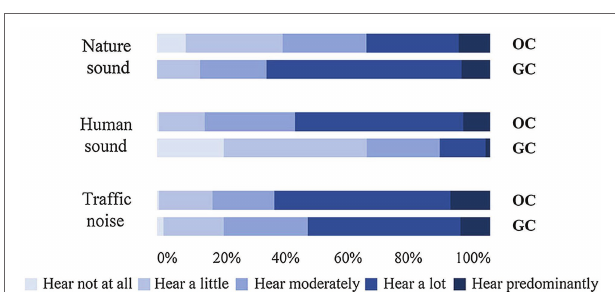
FIGURE 5 | Results of the sound source evaluation stratified by the gated community and the open community and the three sound sources. GC, the gated community and OC, the open community.